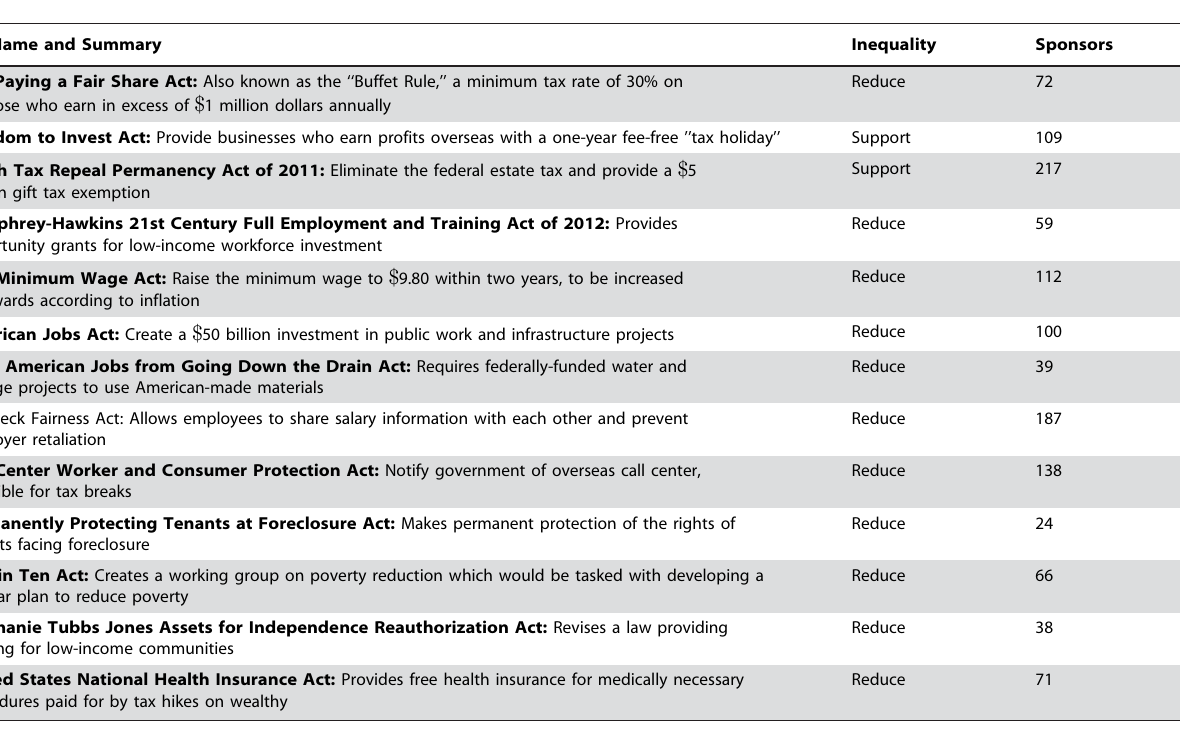
Table 1. Summary of legislative bills where sponsorship of the bill indicates either support for, or reduction of, economic inequality in the